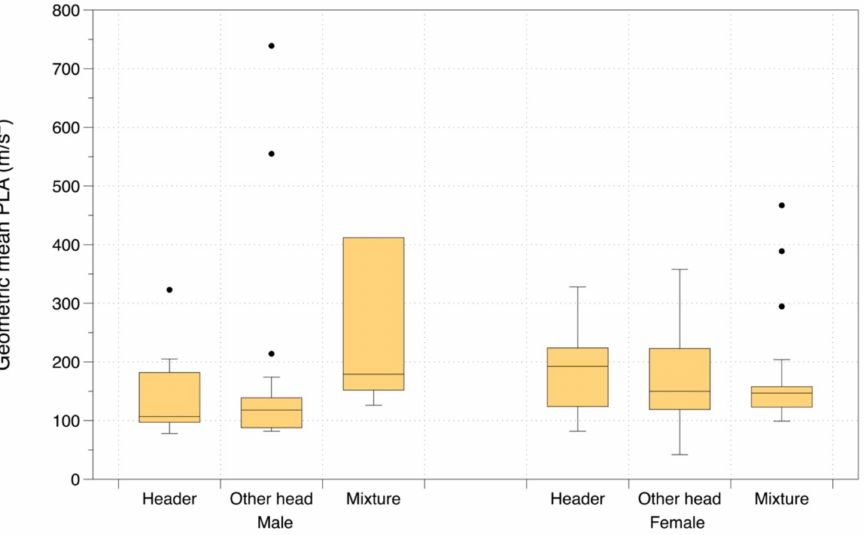
Figure 5. Geometric mean PLA for various types of head impact during play, for male and female players.